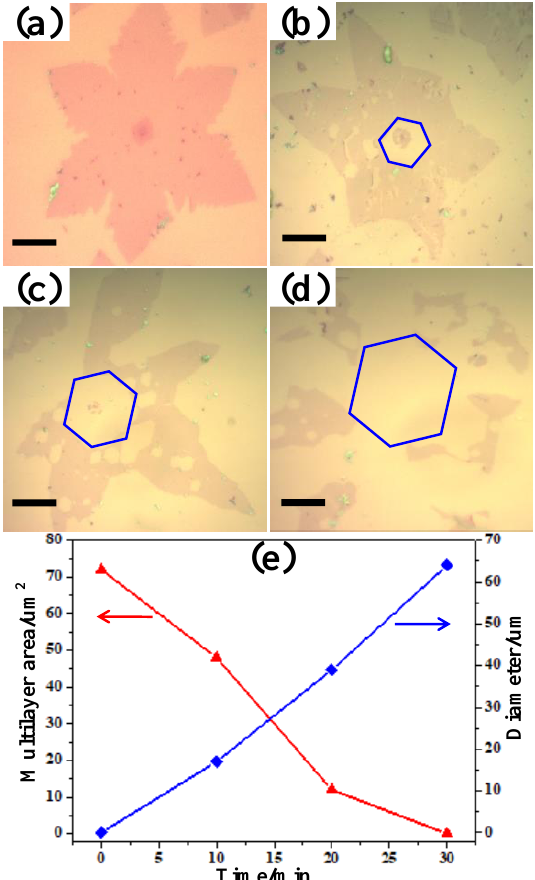
Figure 5. Optical microscope images of as-grown and etched wrinkled multilayer graphene domains transferred to the SiO2 / Si substrate. ( a ) The original grown wrinkled multilayer graphene. ( b – d ) The etched graphene obtained after etching for ( b ) 10 min, ( c ) 20 min, and ( d ) 30 min. ( e ) Statistical data of the area of the multilayer and the diameter of the hexagonal hole along the multilayer area with etching time. All scale bars are 20 μm.